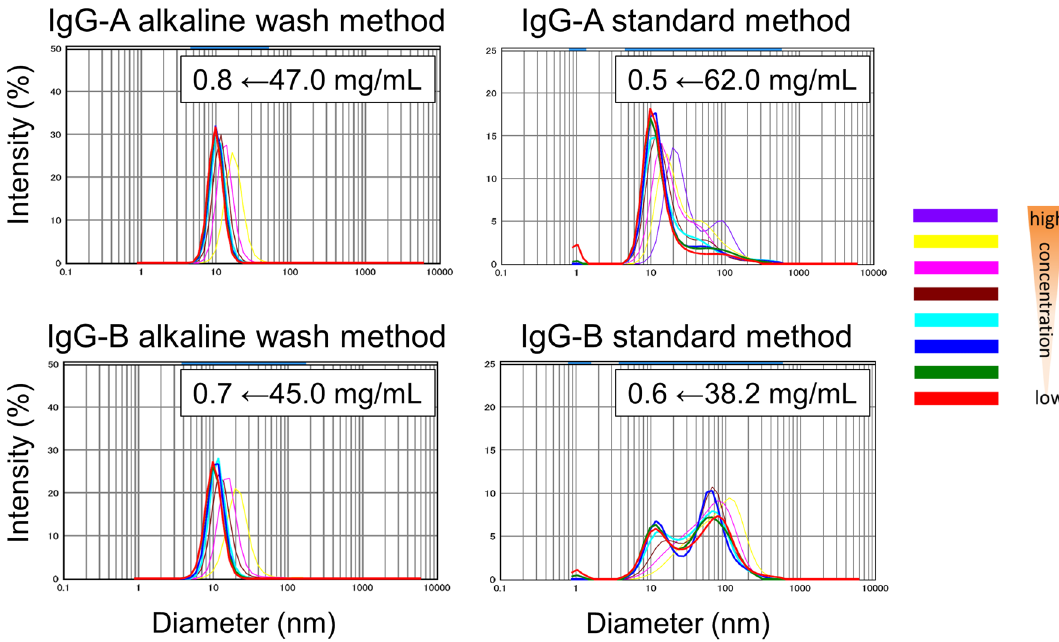
Figure 3. DLS profiles of IgG-A and IgG-B at various concentrations purified by the standard and alkaline wash method.